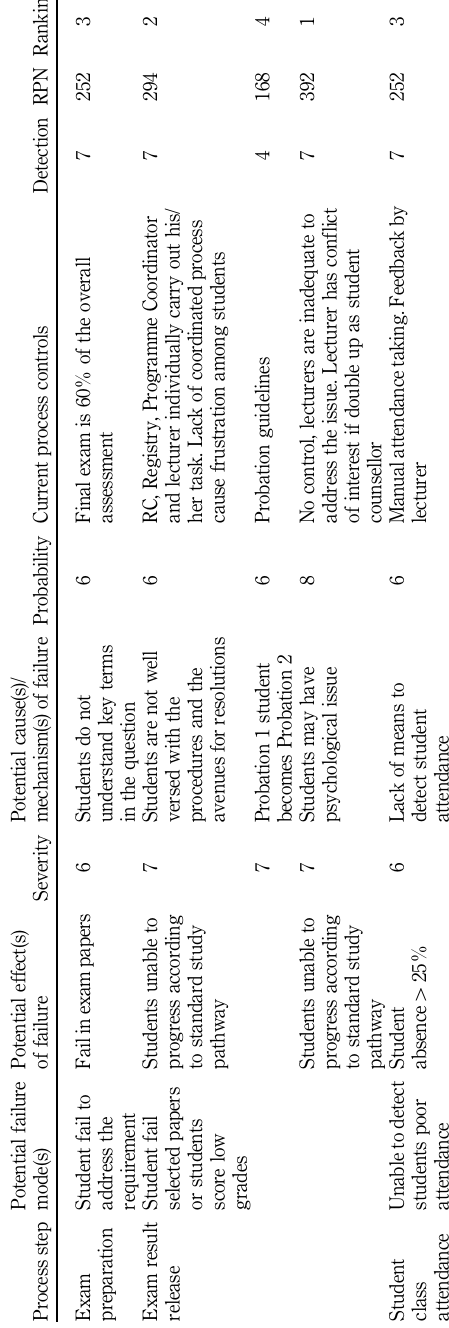
Table I. Part of